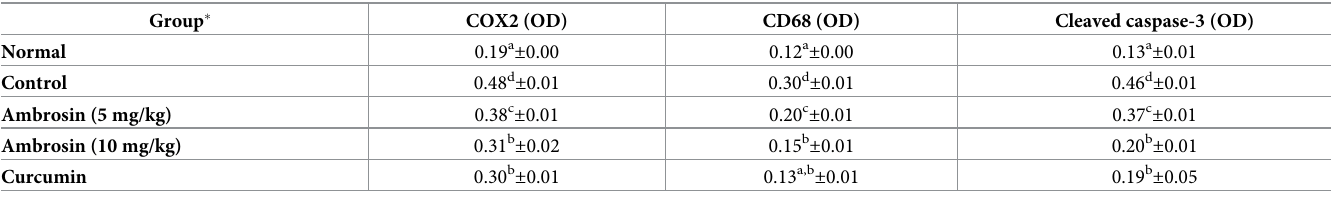
Table 4. Quantification of pro-inflammatory and pro-apoptotic markers traced by immunohistochemical examination of brains of tested groups. Group �